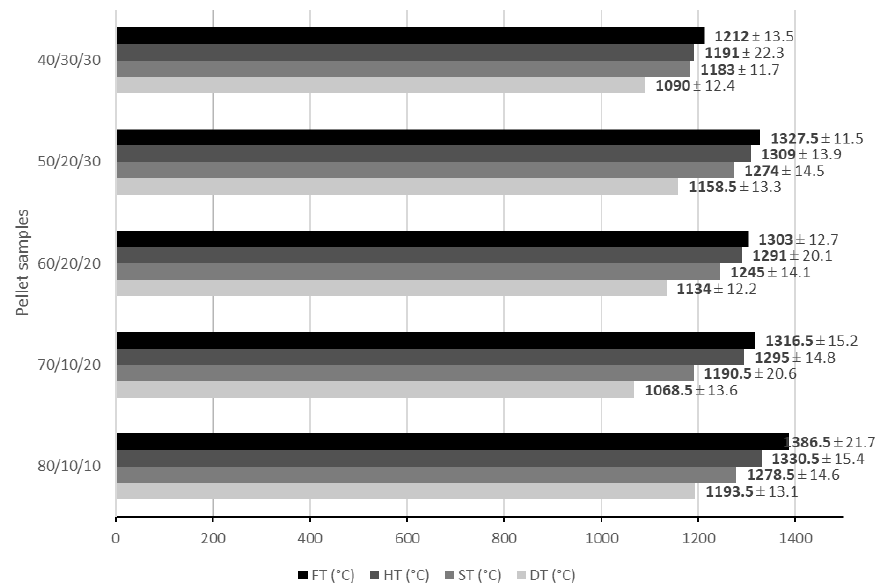
Figure 6. Results from melting temperature analysis of produced